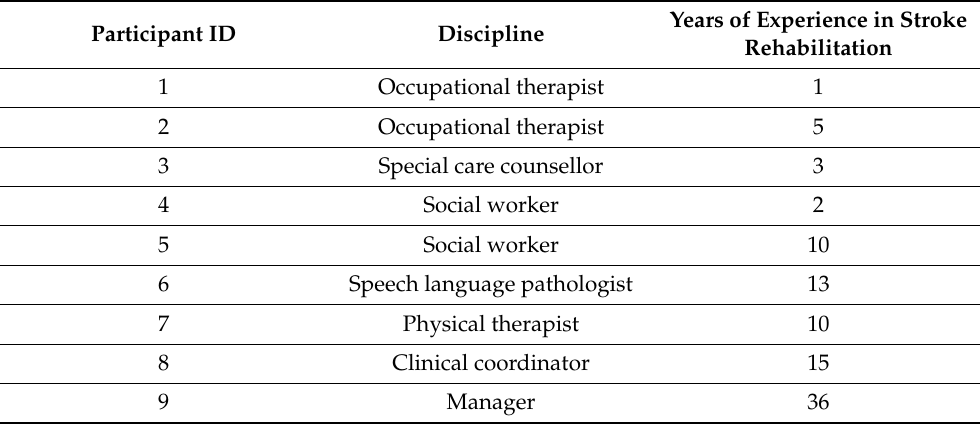
Table 2. Participants’ professional